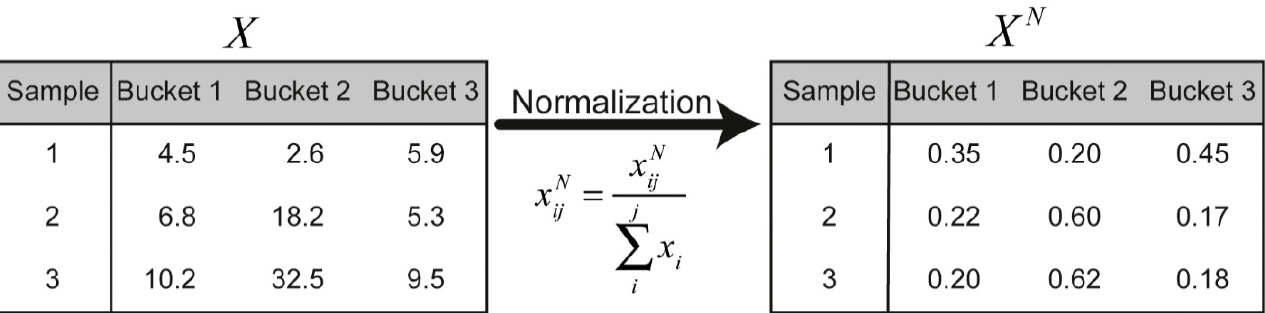
Figure 5. Every data point in the hypothetical bucket matrix X ( i × j ) is normalised by the sum of the intensity of each sample. x ij is an element located in the i th row and the j th column.